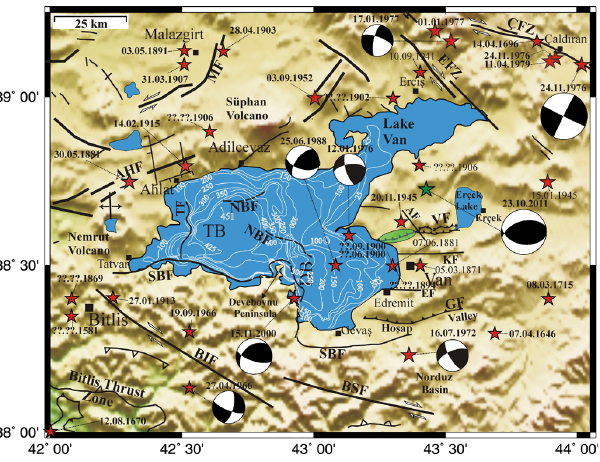
Fig. 2. Local tectonic features, epicentral distribution of large earth- quakes (red and green stars) and available focal mechanisms (black- white beach balls) for the Lake Van area along with the bathymetry of Lake Van. Extent of faults are from Wong and Finckh (1978), Koc¸yi˘git et al. (2011) and MTA (2012), focal mechanisms are from McKenzie (1972), Pınar (1995), Pınar et al. (2007), Utkucu (2013a) and USGS-NEIC and the bathymetry of Lake Van is from Wong and Degens (1978). See Table 2 for the hypocentral parameters of the earthquakes. The green shaded area indicates the area in which surface deformations were observed following the 2011 Van